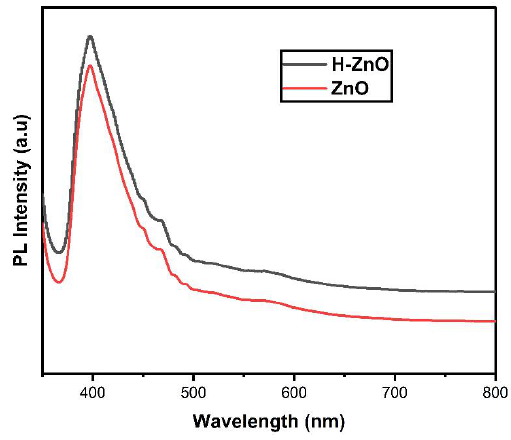
Figure 4. PL spectra of ZnO nanoparticles.